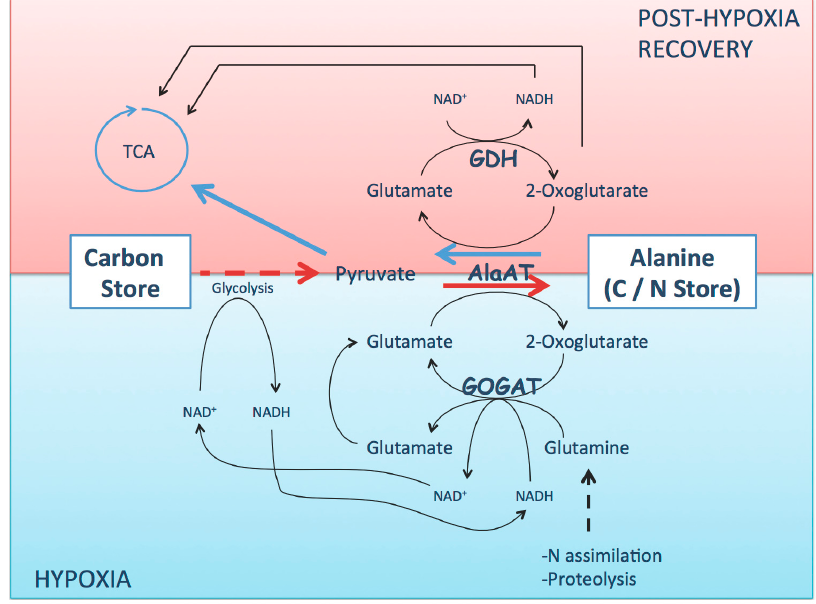
Figure 1. Schematic representation of the central role of alanine during hypoxia and post-hypoxia recovery periods. HYPOXIA: Visualization of carbon flux from carbon storage compounds to alanine through AlaAT/NADH-GOGAT cycle. (POST-HYPOXIA) Visualization of alanine mobilization through AlaAT/GDH cycle and carbon flux towards TCA cycle. Scheme drawn by integrating data from transcriptomic and metabolomic studies and studies combining 15 N and 13 C labeling in various species such as Medicago truncatula , Lotus japonicus , Glycine max and Arabidopsis thaliana . AlaAT: Alanine aminotransferase; GDH: Glutamate Dehydrogenase GOGAT: Glutamne Oxoglutarate Aminotransferase.